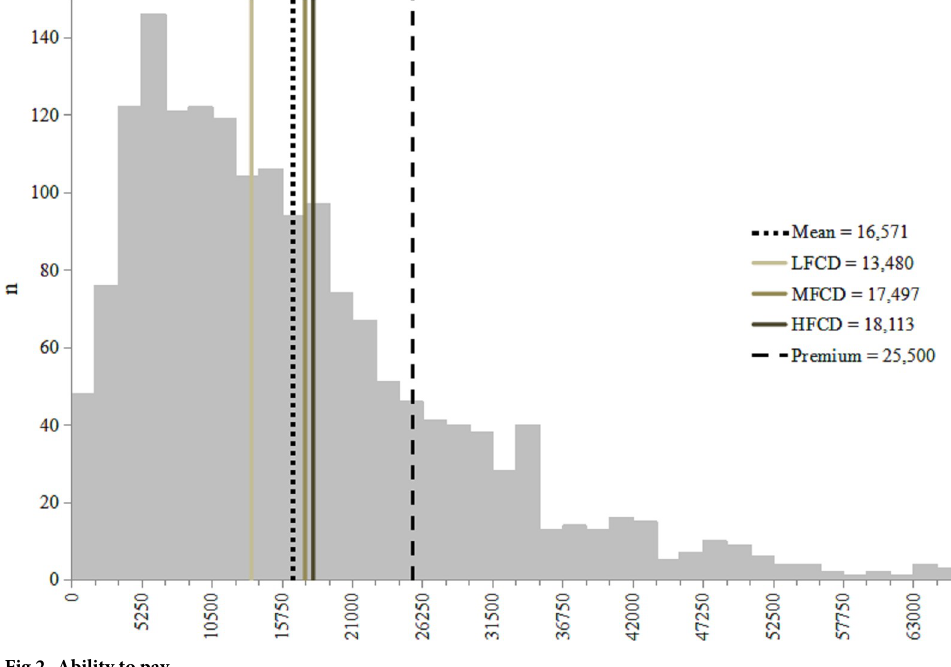
Fig 2. Ability to